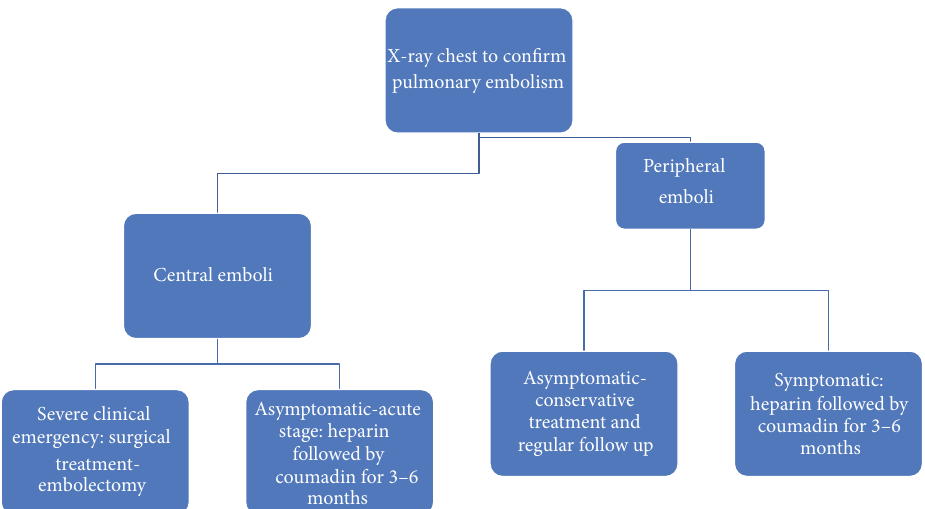
Figure 3: Suggested algorithm for the evaluation and management of patients with cement pulmonary